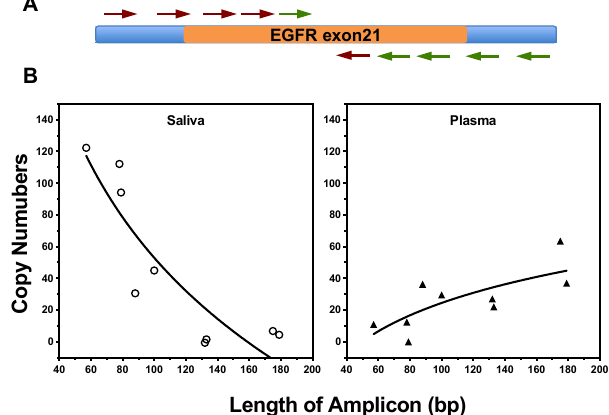
Figure 3. The size distribution of EGFR fragments in saliva and plasma samples from LSCLC patients (two of each biofluid). ( A ) A quantitative real-time PCR method was designed with different amplicons ranging from 55 to 180 bp, covering both sides of exon 21 of EGFR gene. ( B ) Size distribution of EGFR fragments in cfDNA samples from saliva (left) and plasma (right) was measured with qPCR test. The size distribution of EGFR L858R ctDNA was further determined at single-base resolution by NGS analysis using paired plasma and saliva samples from NSCLC patients. The single-stranded DNA library generation method was used for paired-end deep sequencing, which was reported to have more effective recovery of short DNA fragments from plasma samples [37,38]. We used an enrichment procedure that enabled focus on ctDNA with the EGFR L858R mutation only. The results of paired-end sequencing analysis showed a large representation of extremely short DNA fragments harboring L858R mutation in all plasma and saliva tested. The size distribution of these fragments in the two paired plasma and saliva samples examined was found to be